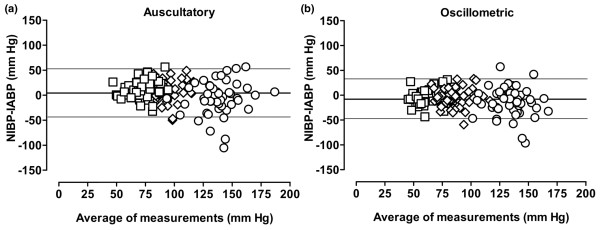
Agreement between auscultatory and oscillometric, and intra-arterial blood pressure measurements. Shown are graphs for the (a) auscultatory method and (b) oscillometric method. The thicker line represents mean bias, and the thinner lines represent upper and lower limits of agreement. Squares are diastolic blood pressure measurement, diamonds are mean arterial blood pressure measurements, and circles are systolic blood pressure measurements. P < 0.001 between methods. IABP, intra-arterial blood pressure; NIBP, noninvasive blood pressure. a and b are not identified in the figure.